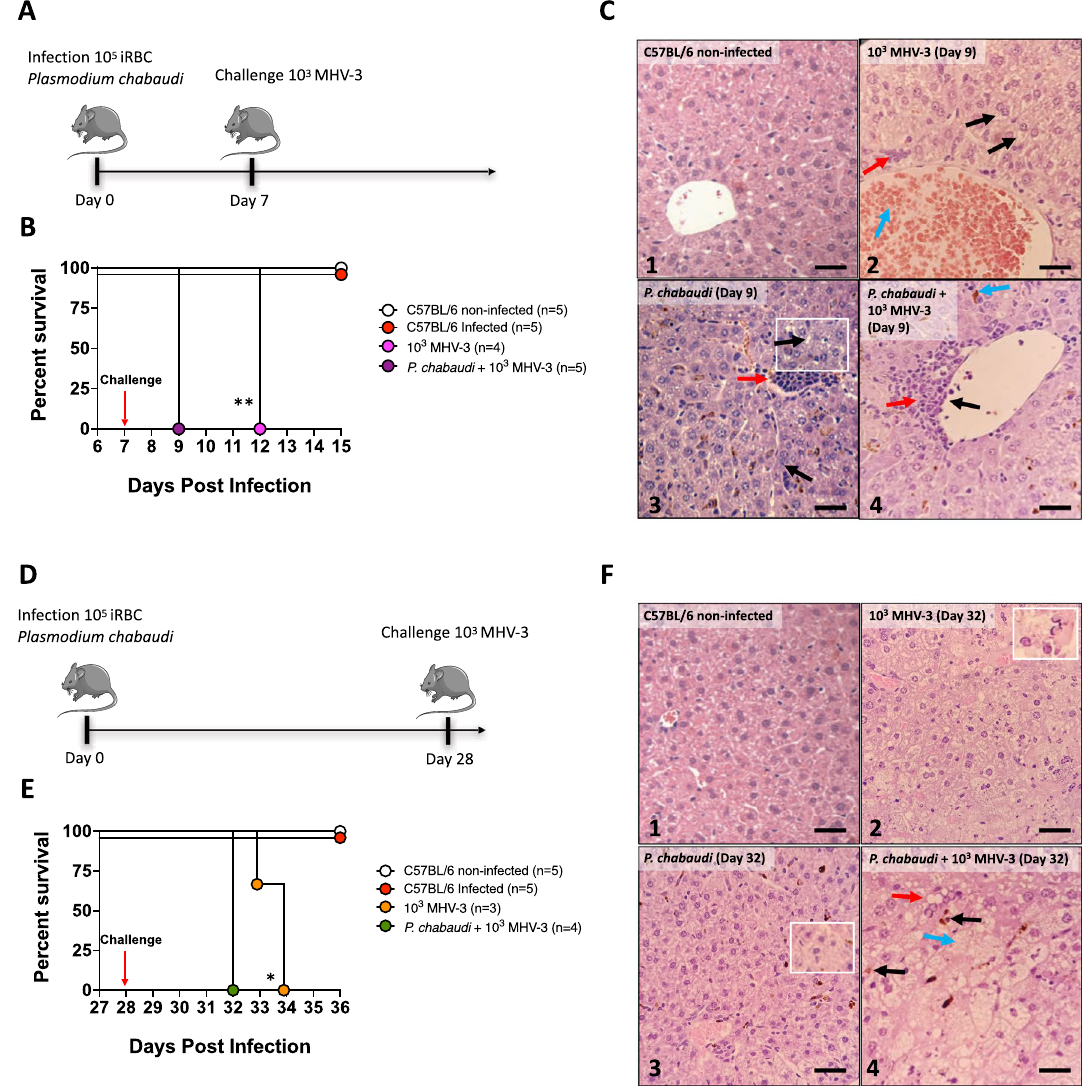
Figure 7. Lethality in P. chabaudi mice challenged with MHV-3. ( A , D ) Experimental protocol of MHV-3 challenge (Log-rank test, * p < 0.05, ** p < 0.01). The scheme was partly generated using Sevier Medical Art, provided by Sevier, licensed under a Creative Commons Attribution 3.0 unported license. Percent survival of mice challenged intraperitoneally with MHV-3 ( B ) 7 and ( E ) 28 days after infection. ( C ) Histology liver sections showing: (C2) Hydropic degeneration (black arrow), hyperemia vessel (blue arrow) and inflammatory cells infiltration (yellow arrow). (C3) Inflammatory focus (yellow arrow), steatosis (black arrow). (C4) Perivascular inflammatory focus (yellow arrow), leukocytes bordering vessel (black arrow) and hemozoin crystals (blue arrow) (HE staining, Bar = 32 µm). ( F ) Histology liver sections showing: (F2) condensed nucleus suggesting apoptosis, (F3) hepatocytes ballooning (HE staining, Bar = 32 µm), (F4) Hemozoin crystals (black arrow), steatosis (yellow arrow), and hydropic degeneration (blue arrow) (HE staining, Bar = 16 µm). Magnification 10X. The data shown are representative of 3 independent